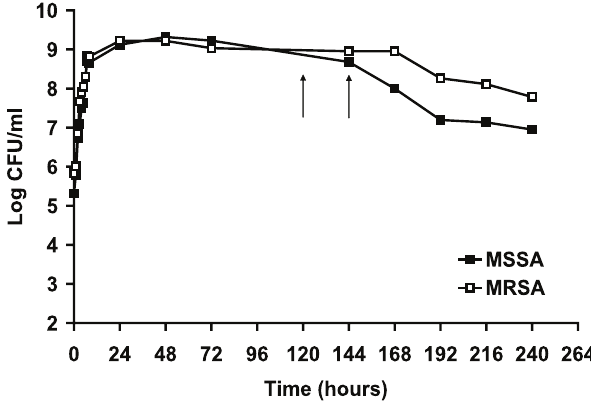
Figure 1. Growth curves of methicillin-sensitive and methicil- lin-resistant S.aureus . The bacterium was grown in nutrient broth medium with shaking for 10 days. The arrows indicate the timepoints when the cultures were used for drug sensitivity test. These results were confirmed in two independent experiments.